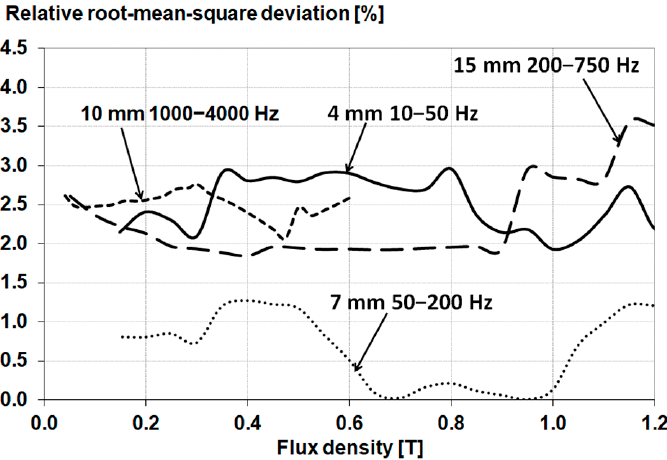
Figure 3. The values of the relative mean square error for the approximation by a linear function for individual induction values.